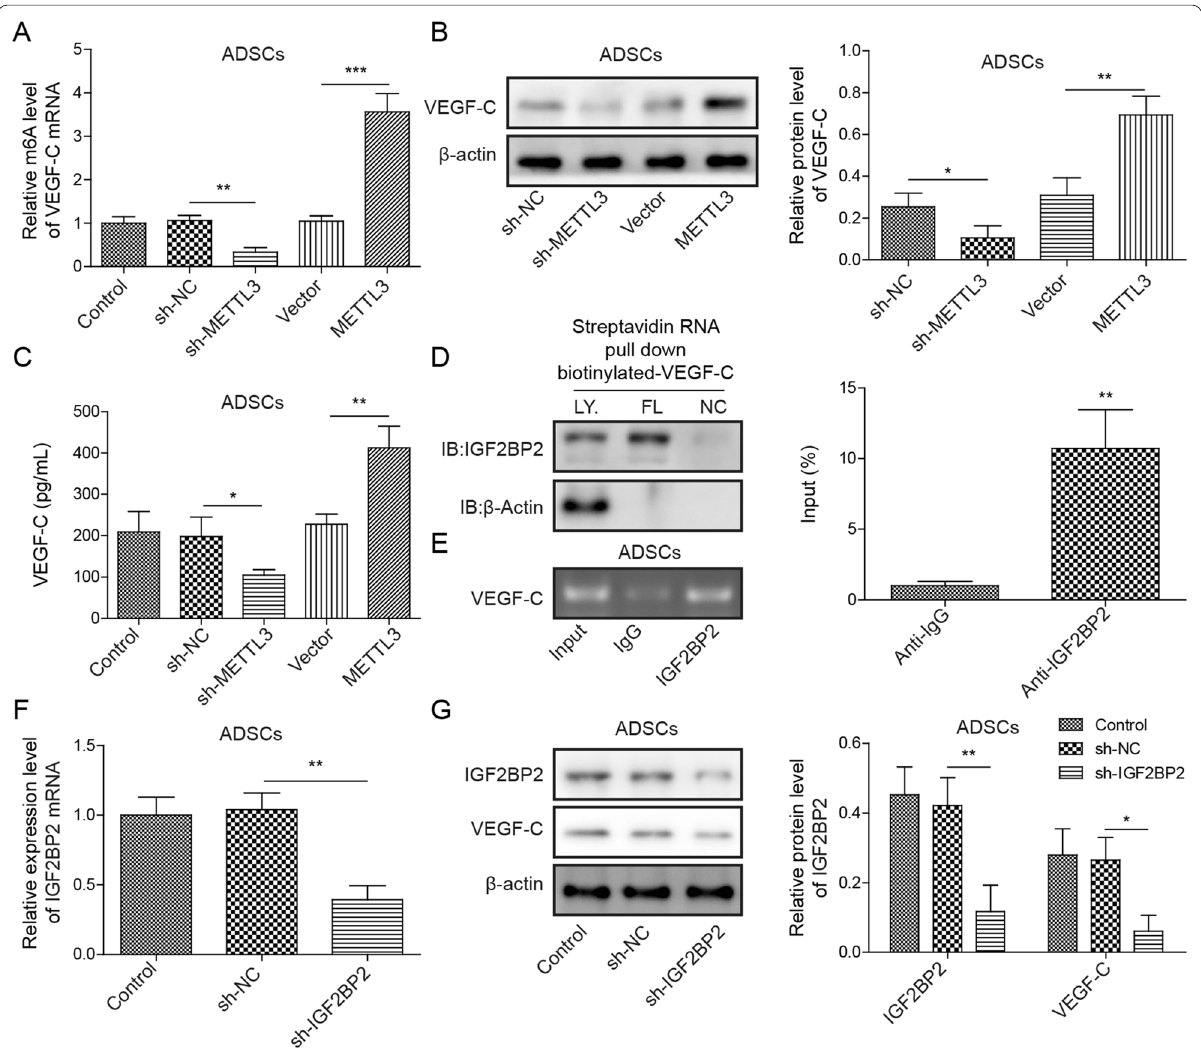
Fig. 3 ADSCs regulate VEGF-C expression via the METTL3/IGF2BP2-m6A pathway. sh-METTL3 and pcDNA-METTL3 plasmids were transfected into ADSCs for METTL3 knockdown and overexpression, respectively. sh-NC served as the negative control for sh-METTL3, and the pcDNA-empty vector served as the negative control for pcDNA-METTL3 plasmids. A MeRIP-qPCR was performed to assess the m 6 A levels of VEGF-C mRNA. B Western blotting was conducted to measure the levels of VEGF-C proteins. C An ELISA was carried out to assess the levels of VEGF-C in the supernatant of ADSCs. D , E RNA pulldown and RIP assays were performed to evaluate the interaction between VEGF-C and IGF2BP2. Immunoblotting of IGF2BP2 after RNA pulldown assay with cell lysate (Ly) and full-length biotinylated VEGF-C (FL); NC indicates the beads. sh-IGF2BP2 plasmids were transfected into ADSCs for IGF2BP2 knockdown, and sh-NC served as the negative control for sh-IGF2BP2 plasmids. F RT-qPCR was performed to assess the levels of IGF2BP2. G Western blotting was conducted to measure the protein levels of IGF2BP2 and VEGF-C. Data represent the mean of three independent experiments. Error bars represent SD. * P < 0.05, ** P < 0.01 or *** P <